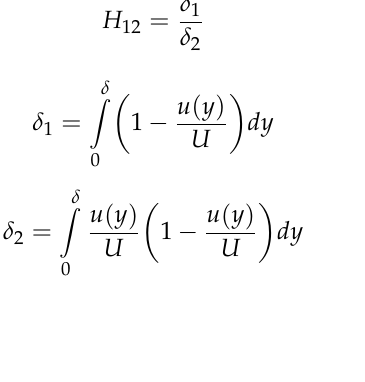
Figure 8. Planes on which boundary layer transition was investigated.